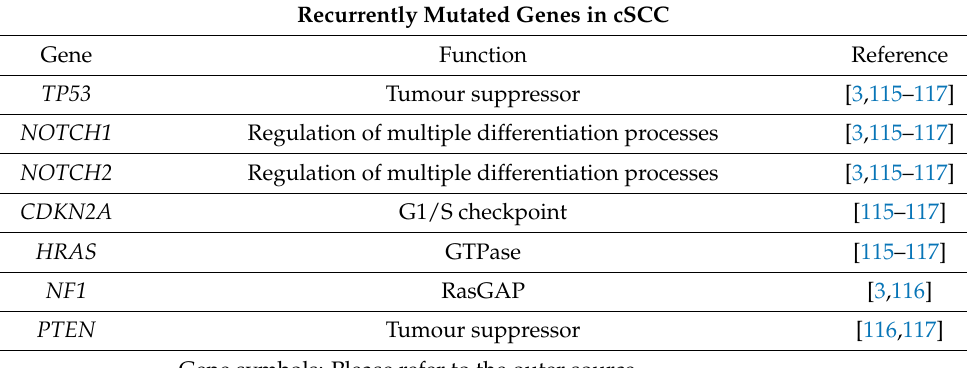
Table 3. Recurrently mutated genes in cSCCs.